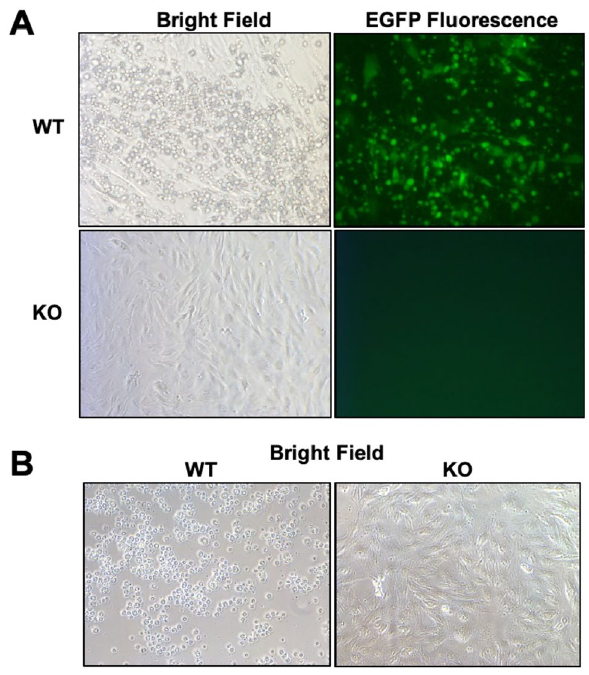
Figure 2. Infection of WT and KO cells with SVA-EGFP. Photomicrographs taken (A) 8 h and (B) 24 h after infection of fibroblast cells with SVA isolate, KS15-01-EGFP. The KO cells were generated from Pig 1–3 (52) (Fig. S1 and Table